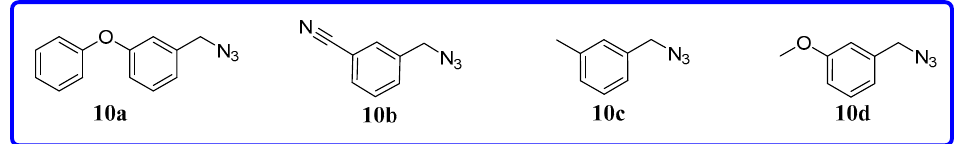
Figure 5. Azides 10a~d in the present study.